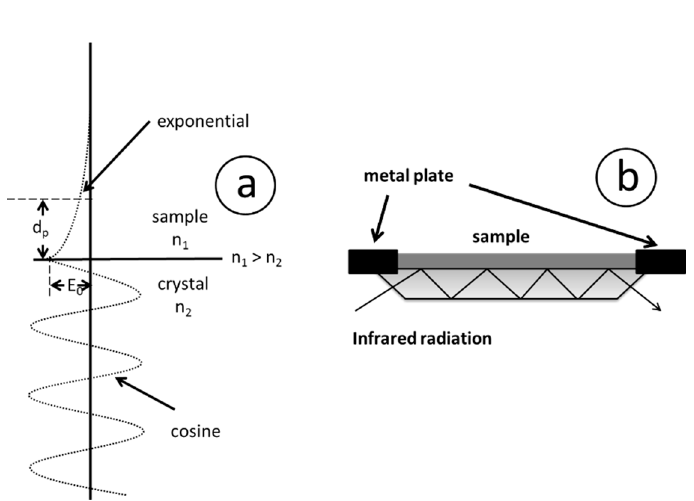
Figure 3. ( a ) Illustration of the evanescent wave; ( b ) principle of attenuated total reflection